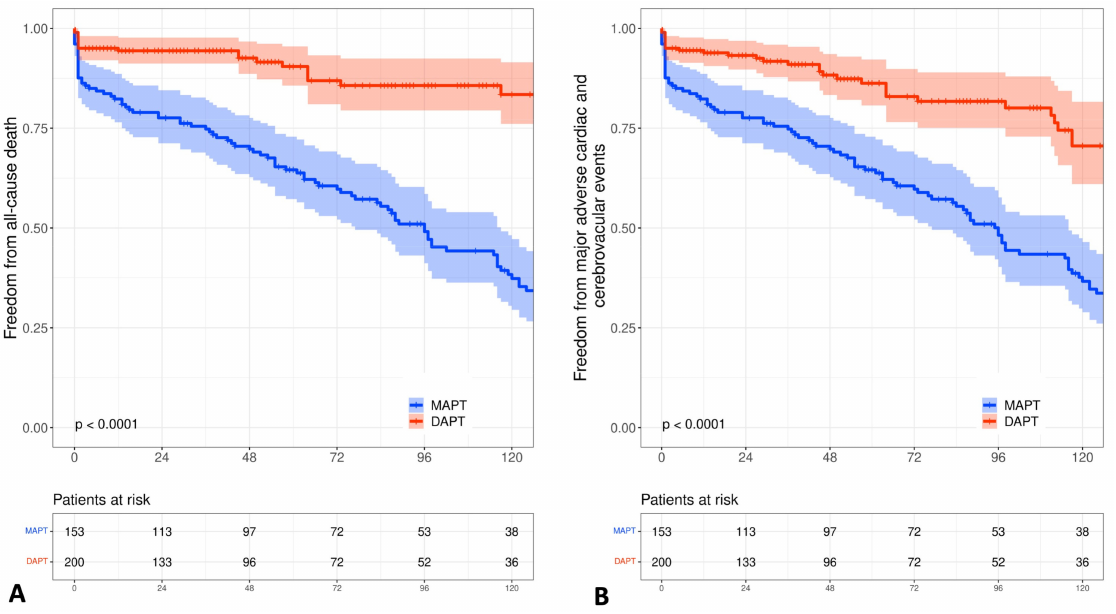
Figure 4. Kaplan-Meier curves illustrating difference between patients received dual-APT (DAPT) and single- or mono-APT (S/MAPT) groups regarding: ( A ) Estimated survival. ( B ) Freedom from MACCE.